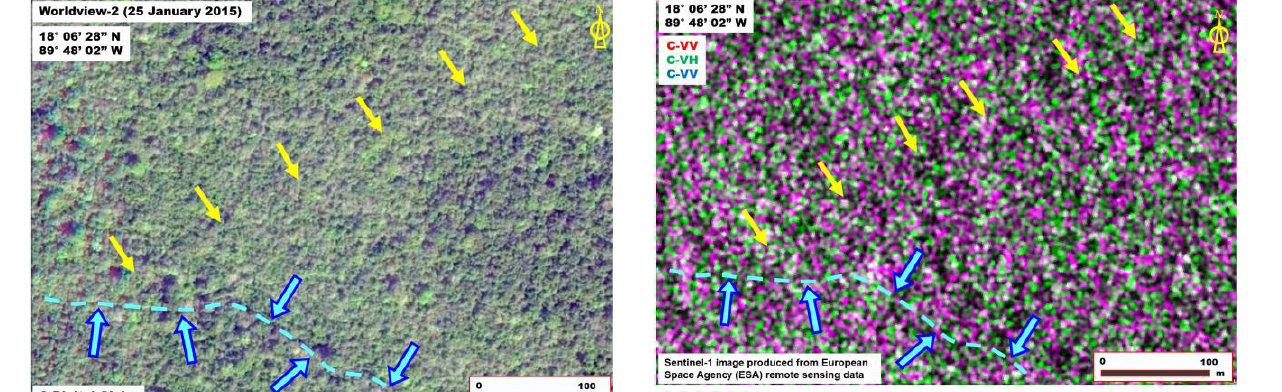
Figure 13. Comparison between an access road (blue arrows) and the nearby sacbe segment #3 (yellow arrows) of Folan et al. (1995) located in a forested area on a false-colour composite made with the Sentinel-1A image acquired in May 2016, with the C-VV band in red and blue, C-VH band in green. The location of the sacbe is indicated by yellow arrows.